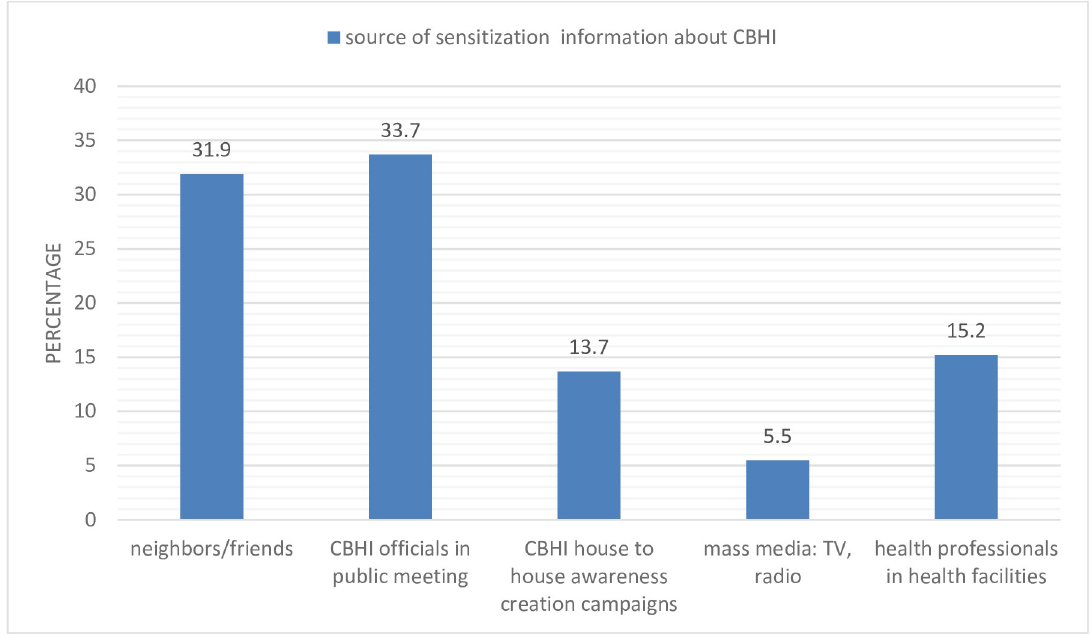
Fig 1. Source of information regarding CBHI in Segen area and South Omo Zones, Southern Ethiopia, 27 April to 12 June, 2018.